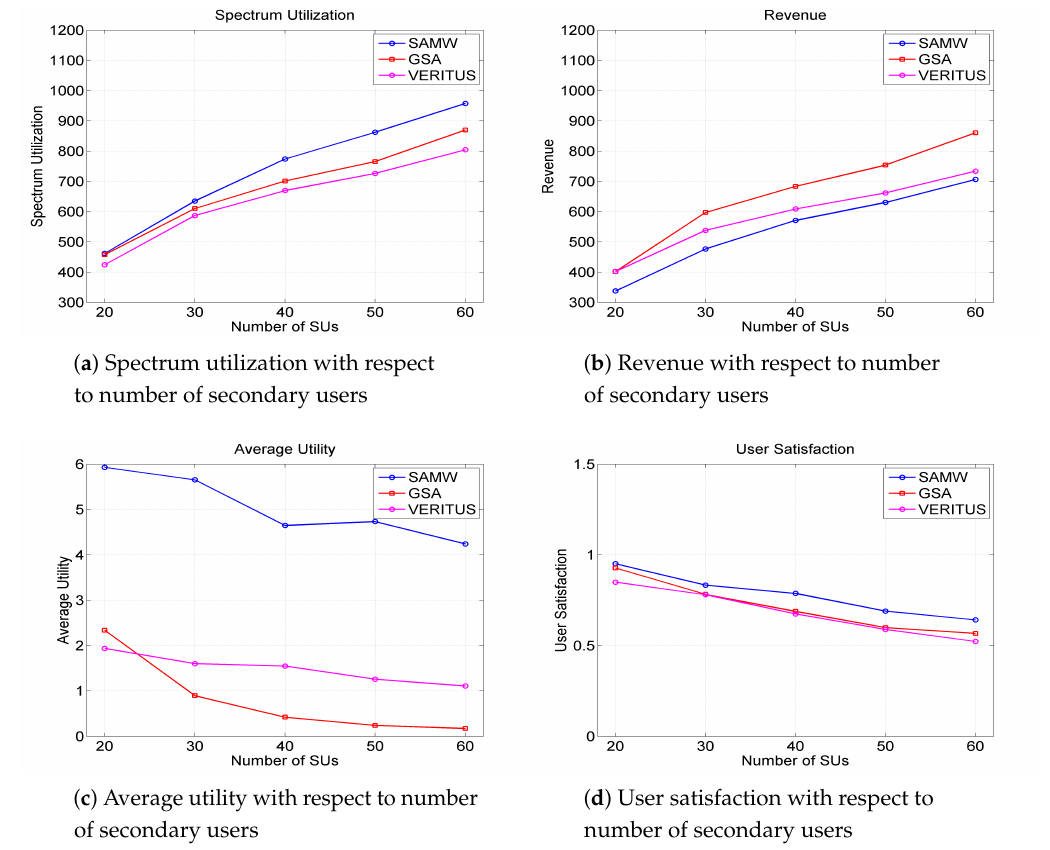
Figure 8. Spectrum utilization, revenue, average utility, and user satisfaction for SAMW, GSA, and VERITUS with respect to number of secondary